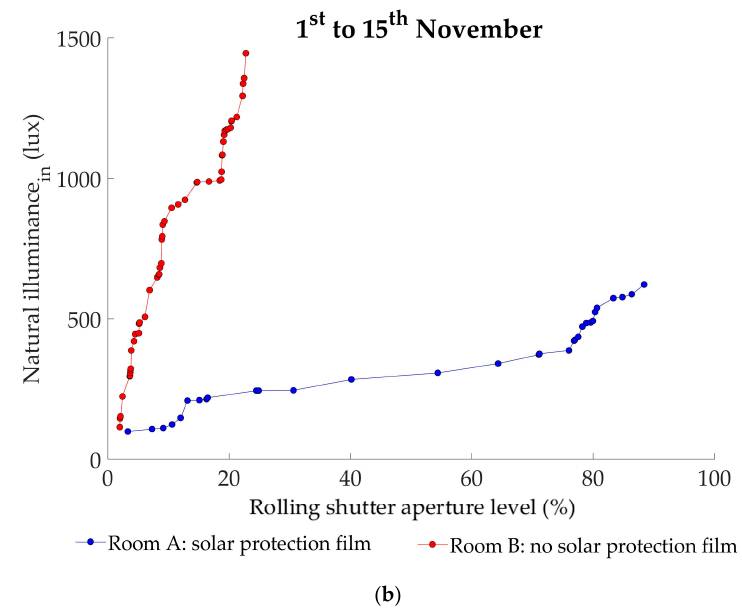
Figure 6. Mid-season period: ( a ) Outdoor and indoor natural illuminance; ( b ) Cumulative distribution of rolling shutter aperture levels (%) and indoor natural illuminance. Source: Authors.